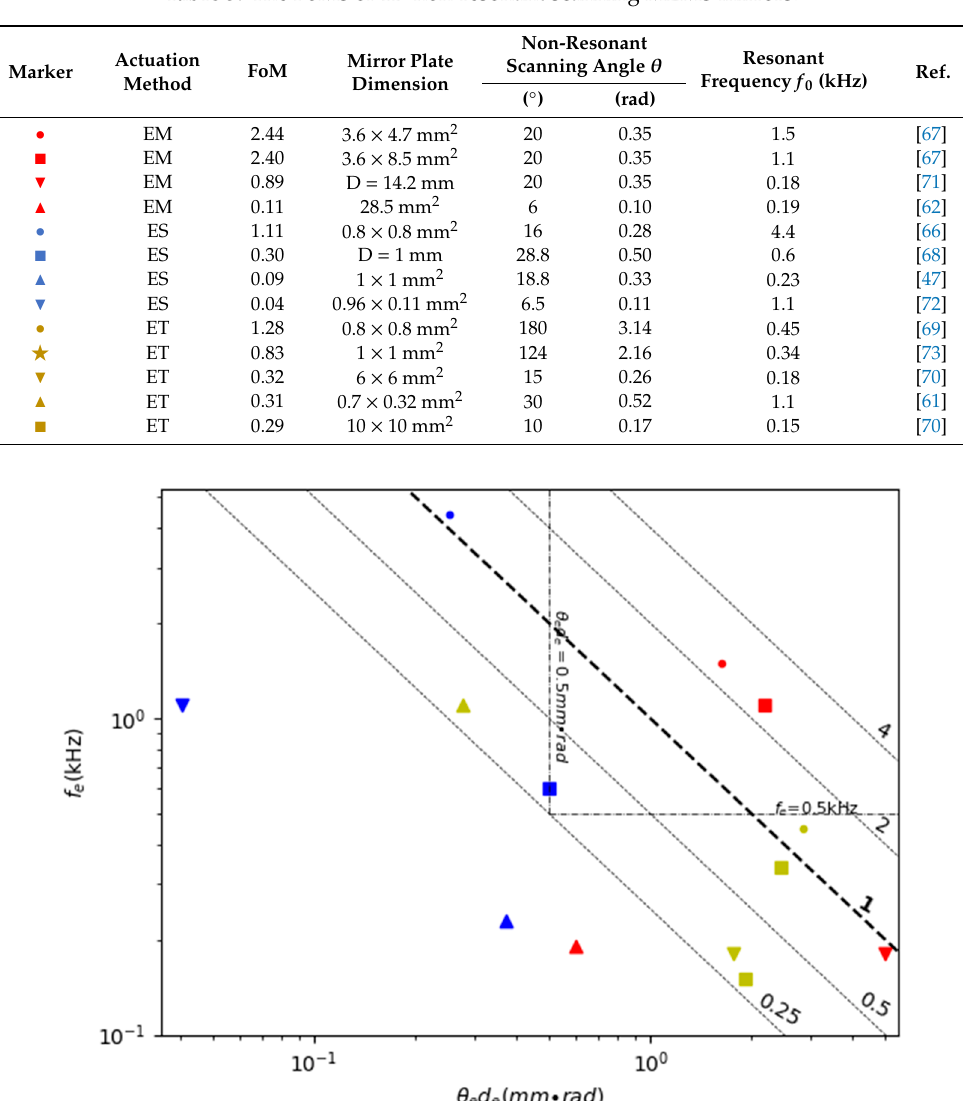
Figure 8. High FoM 1D non-resonant MEMS mirrors. ( a ) An electromagnetic actuator [67] (Image courtesy of Maradin, Yokneam, Israel); ( b ) An electrostatic MEMS mirror [68]; ( c ) An electrothermal MEMS mirror with a 180° non-resonant optical scanning angle [69]; ( d ) An electrothermal MEMS mirror with a mirror size of 10 × 10 mm 2 [70]. 4. 2D MEMS Mirrors for LiDAR This section will first discuss the architecture of LiDAR systems based on 2D MEMS mirrors. Similar to 1D MEMS mirrors, 2D MEMS mirrors can scan either axis in a resonant mode or non- resonant mode. Thus, there exist three scanning modes: resonant scans in both axes, resonant scan in one axis/non-resonant scan in the other axis, and non-resonant scans in both axes. Sections 4.2 to 4.4 will discuss 2D MEMS mirrors working in those three scanning modes in detail. 4.1. Architecture of LiDAR with 2D MEMS Mirrors LiDARs with 2D scanning MEMS mirrors always use collimated laser sources. The laser beam incident on the MEMS mirror with a similar size as the MEMS mirror, as shown in Figures 9(a) [74] and (b) [75]. With multiple lasers with different incident angles, the overall scanning FoV can be ( b ) ( a )